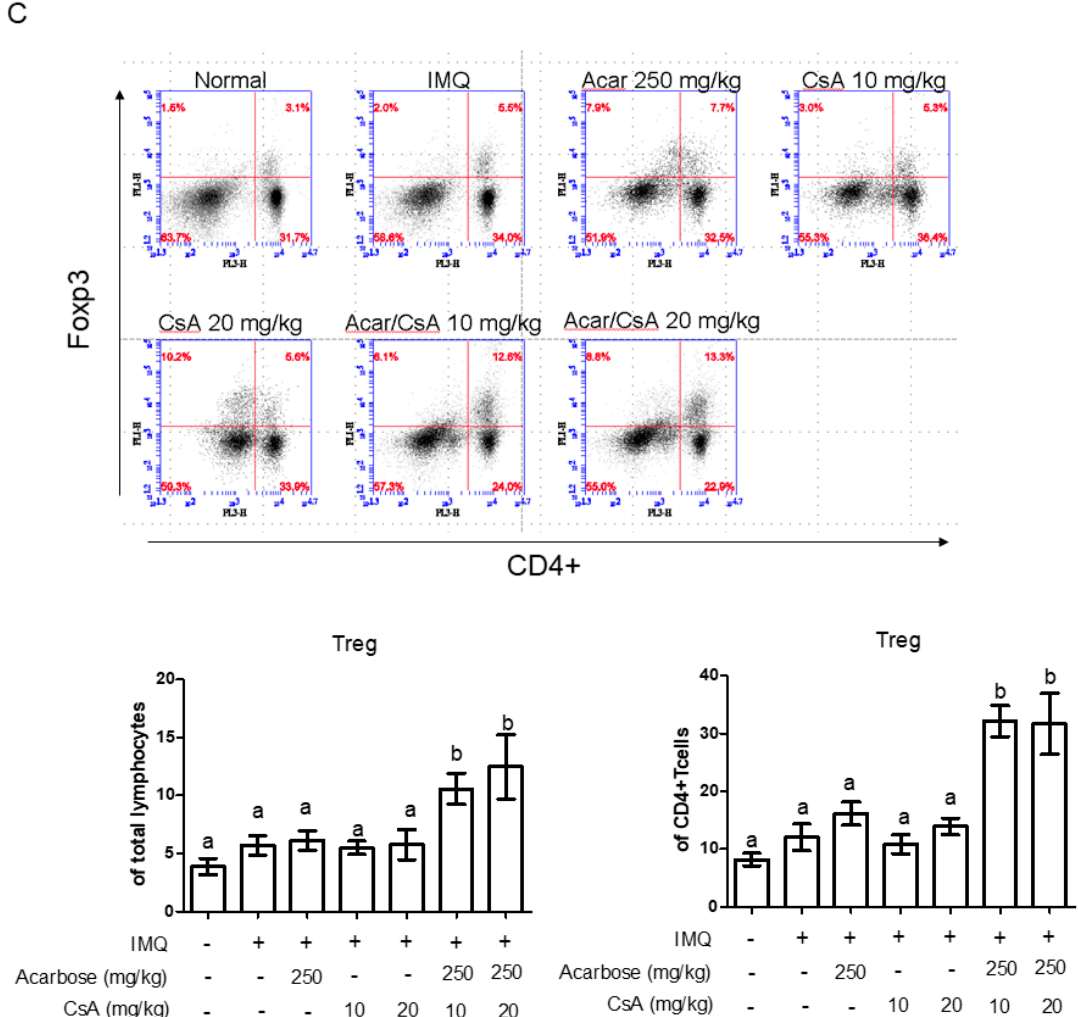
Figure 5. Effects of Acar (250 or 500 mg/kg) and/or low-dose CsA (10 or 20 mg/kg) on IL-17A + T-cells ( A ), CD4 + IL-22 + T-cells ( B ), and Treg cells ( C ) in mice with IMQ-induced psoriasis-like dermatitis. IMQ-induced mice were randomly assigned to the following six groups ( n = 6): IMQ alone, Acar (250 mg/kg/day), CsA (10 mg/kg/day), CsA (20 mg/kg/day), Acar (250 mg/kg/day) + CsA (10 mg/kg/day), and Acar (250 mg/kg/day) + CsA (20 mg/kg/day). Acar was administered to the mice orally once a day for 9 consecutive days by gavage in 200 μ L of water, either alone or in combination with CsA. Experimental data are expressed as mean ± SD ( n = 6), and data analysis was performed using the Mann–Whitney U test. Columns with different superscript letters (a, b, c) are significantly different at p < 0.05.